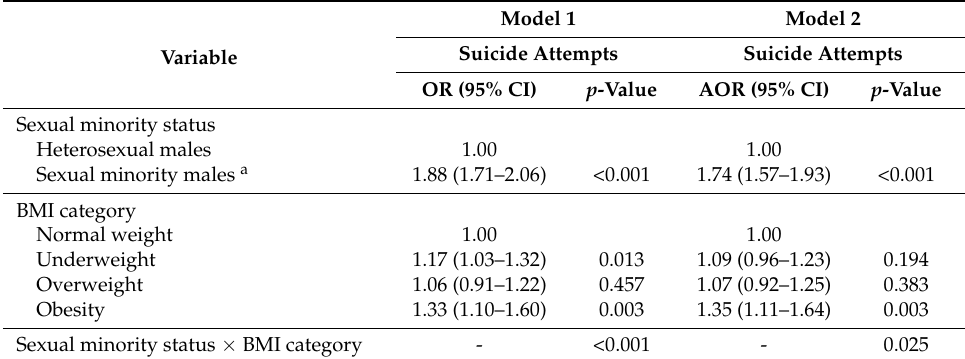
Table 2. Association of sexual minority status, BMI category, and their interaction with suicide attempts among male adolescents (N = 72,409).